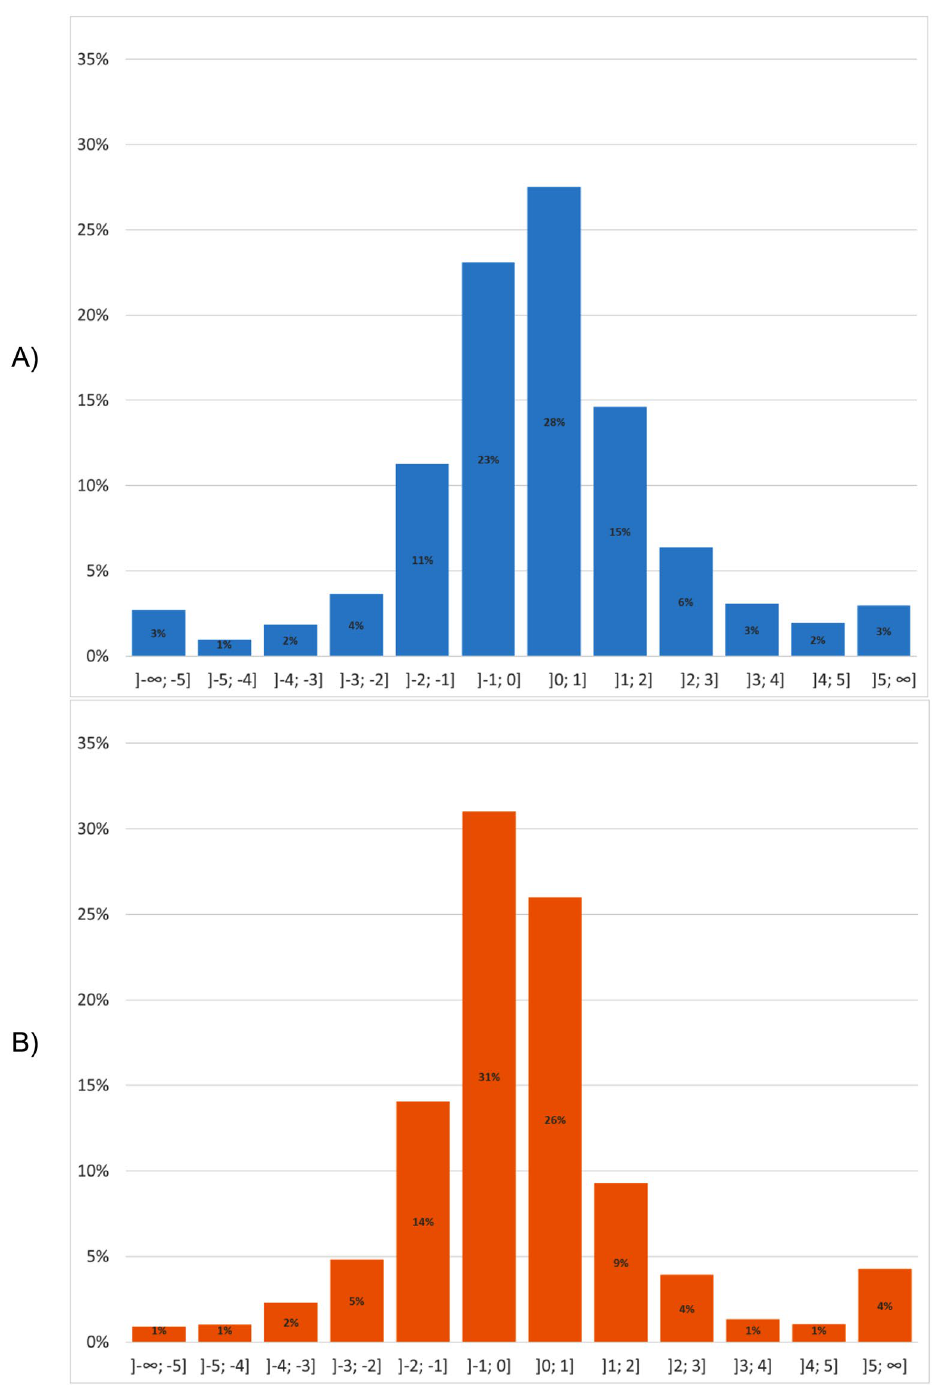
Figure 2. Deviation of time shifts for ( A ) starting and ( B ) ending point prediction with AdaBoost model for all stoppages found in 47 test matches. In 77% (start) and 81% (end) the shift is between ± 2